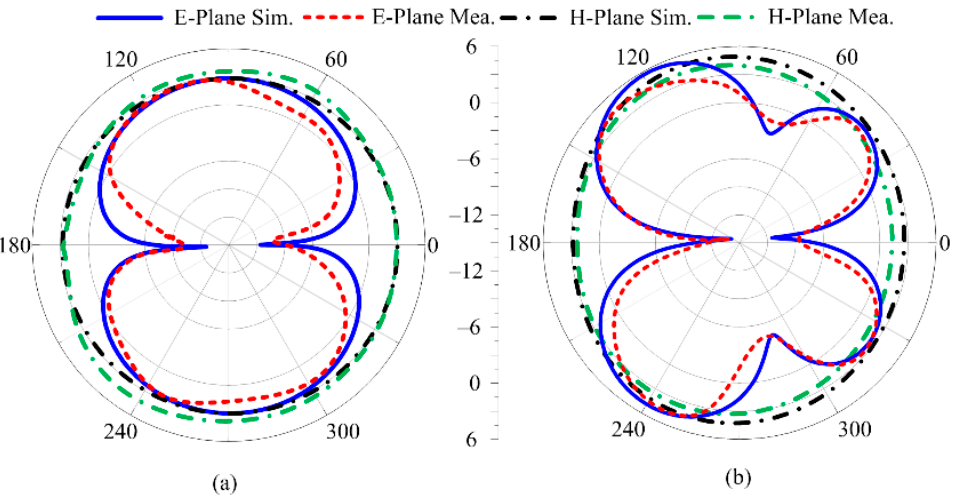
Figure 11. Simulated and measured radiation pattern of prosed dual-band antenna at ( a ) 2.4 GHz ( b ) 5.2 GHz.